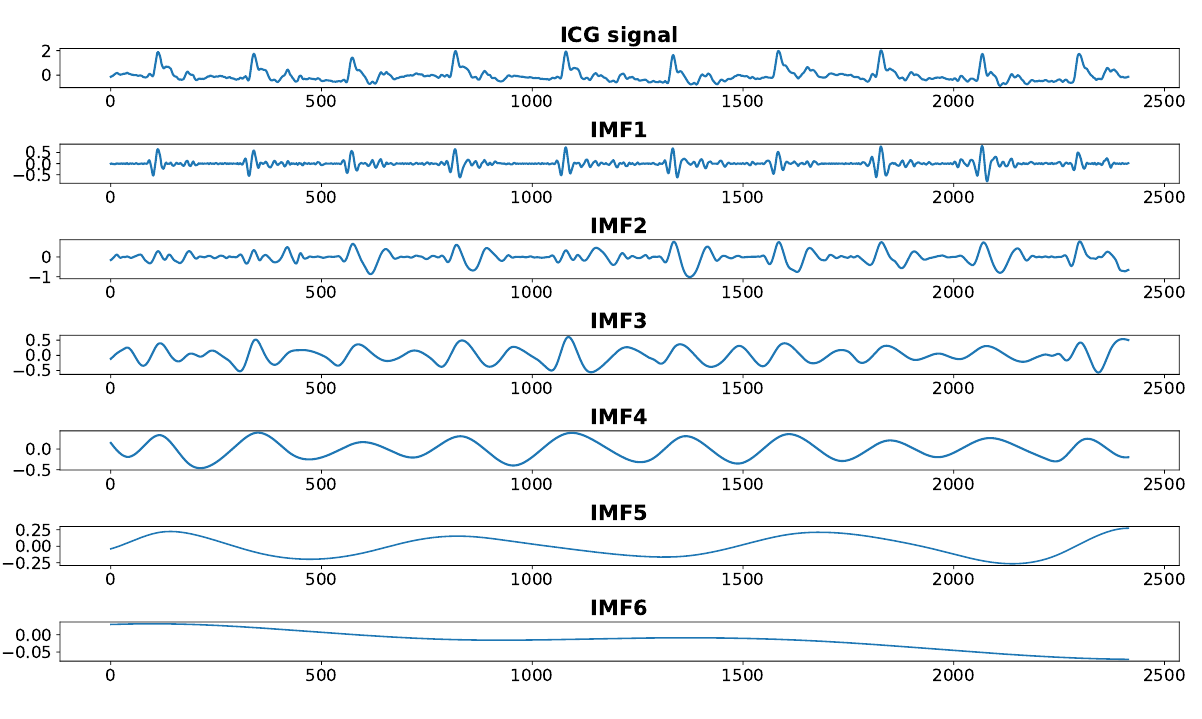
Figure 4. First 6 IMFs obtained from EMD of an ICG recording.